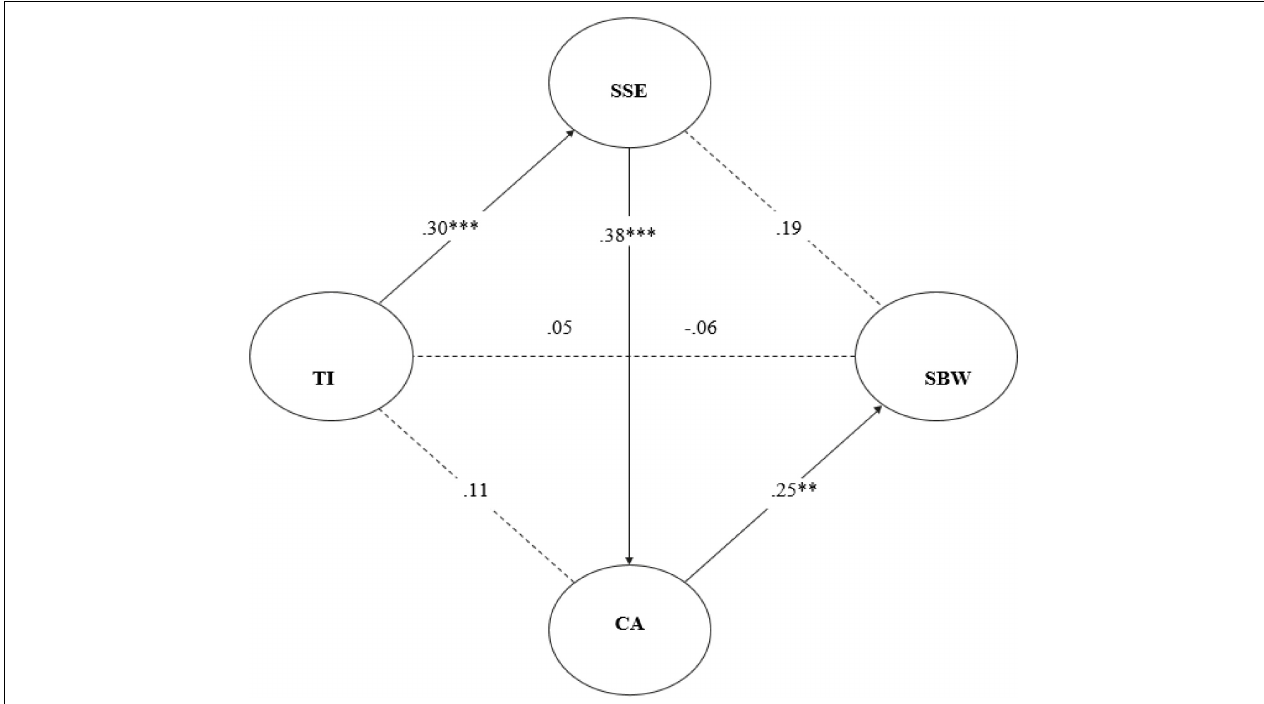
FIGURE 2 | Relationship between TI and SBW mediated by SSE and